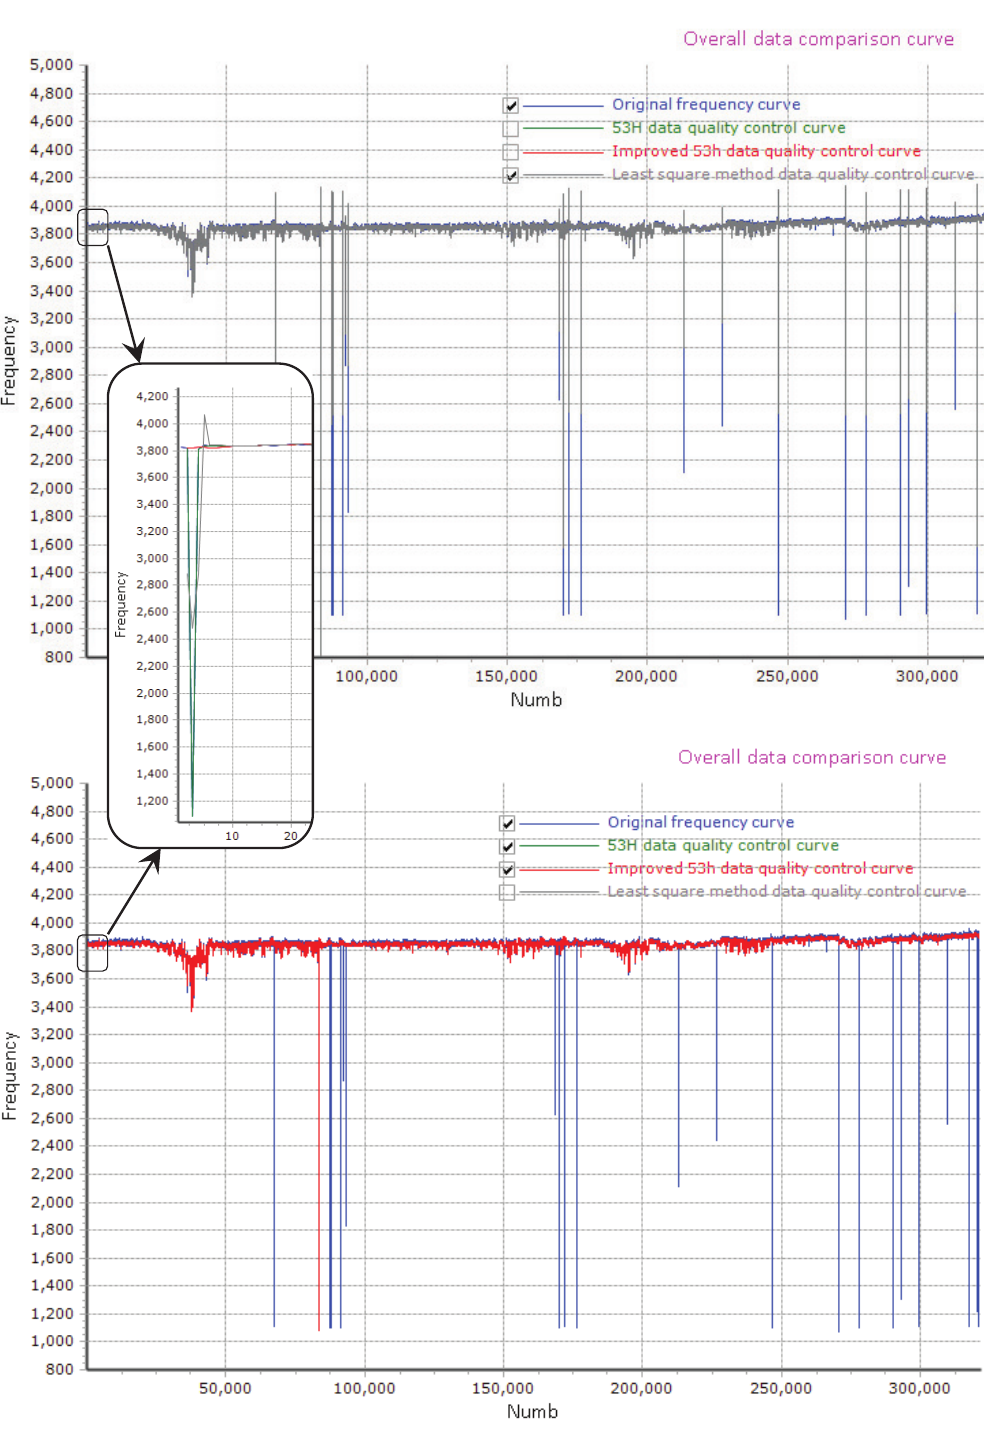
Figure 12. The comparison data curve of the dissolved oxygen